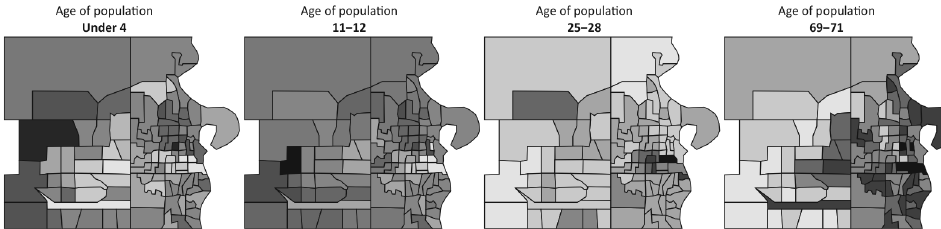
Fig. 4. Example of a non-temporal animation (selected frames) presenting the placement of various age groups in the city of Omaha